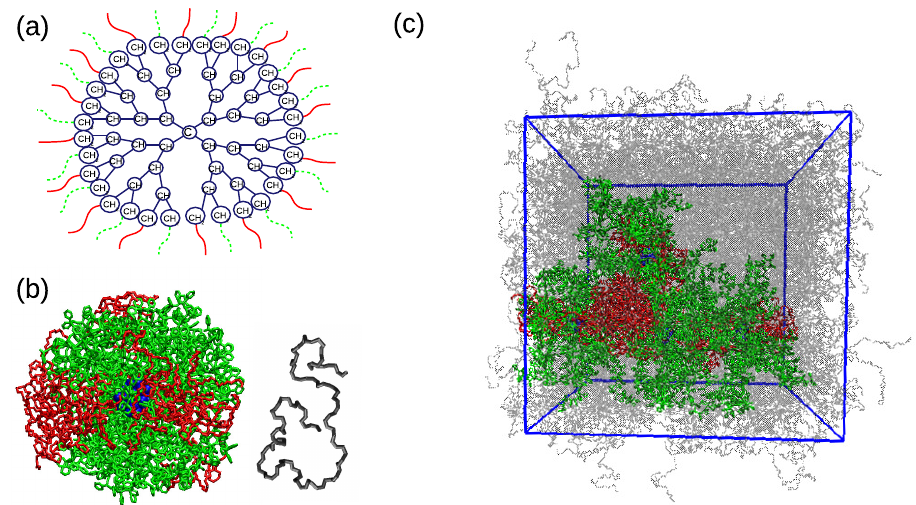
Figure 1. Illustration of the system’s components and the simulation system. ( a ) Drawing of the central dendritic core; ( b ) initial configurations of a mikto-arm star and a PB chain. The PEO arms are painted red, the PS arms green, the central core blue. ( c ) A representative snapshot of an equilibrated s4/PB system. The PB matrix is transparent for a better